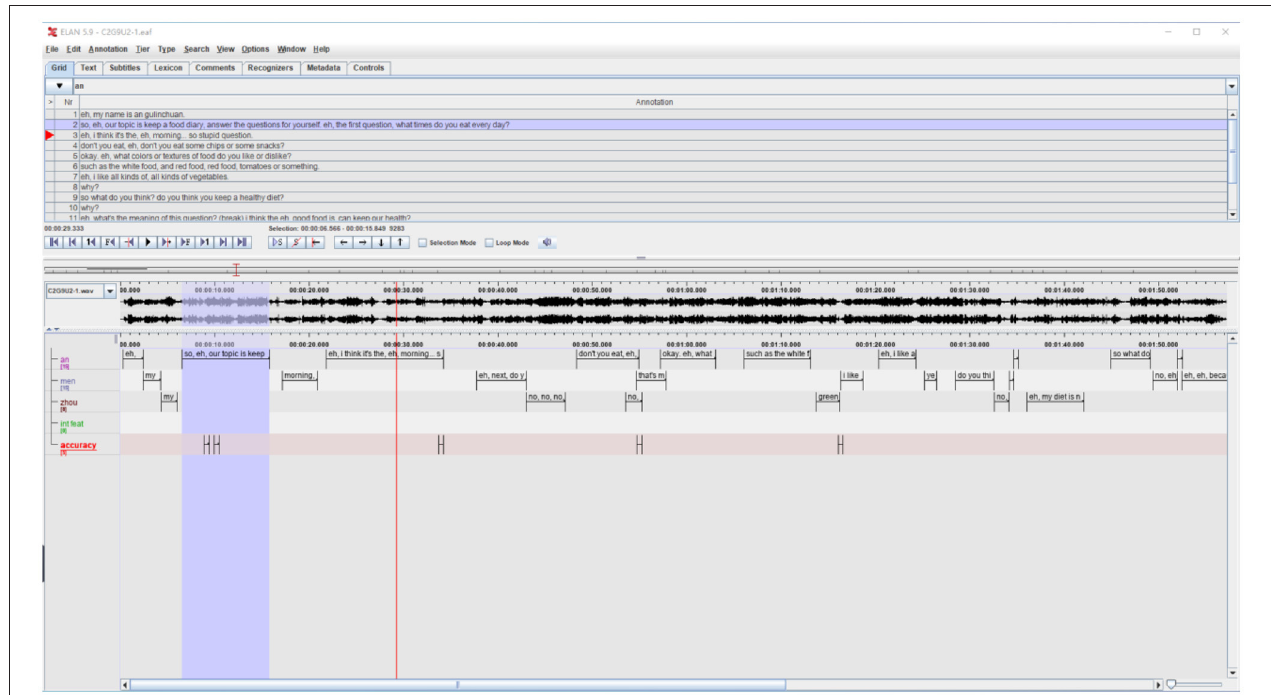
FIGURE 4 | Screen capture of ELAN workspace. Reproduced with